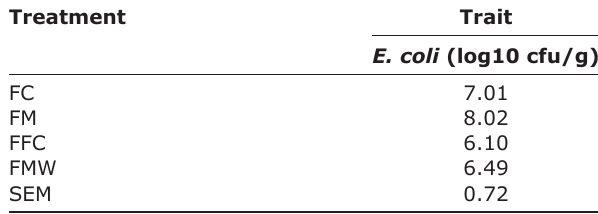
Table-6: Cecum microflora mean (±SEM) of Ross 308 broilers fed with different treatments enriched with agroindustrial wastes from postnatal 1 st -6 th